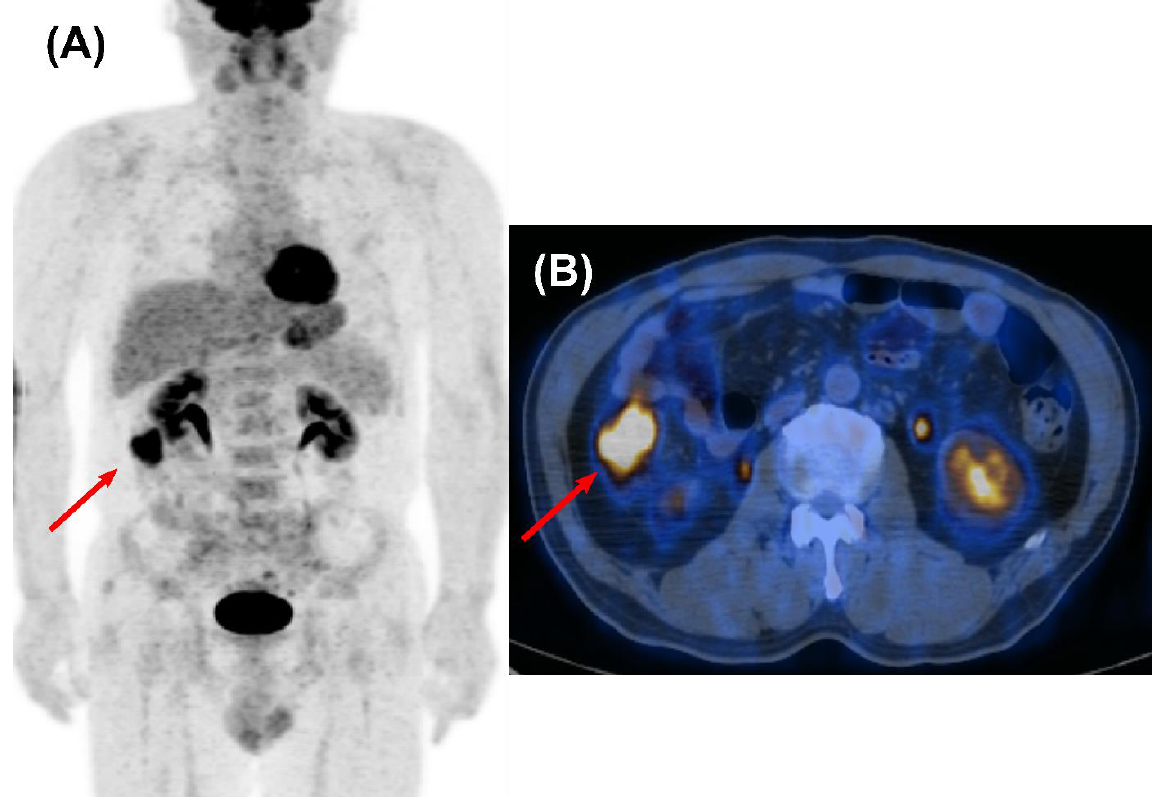
Figure 3. Second primary colon cancer detected by surveillance FDG PET/CT in a 52-year-old male who underwent curative surgery for NSCLC. A maximum intensity projection (MIP) ( A ) and a transaxial fused PET/CT image ( B ) obtained at 4 years after curative resection demonstrated a hypermetabolic lesion on the ascending colon without evidence of metastasis (red arrow). It was identified as primary colon cancer after surgical resection, and he has survived for more than 10 years after initial diagnosis of NSCLC.